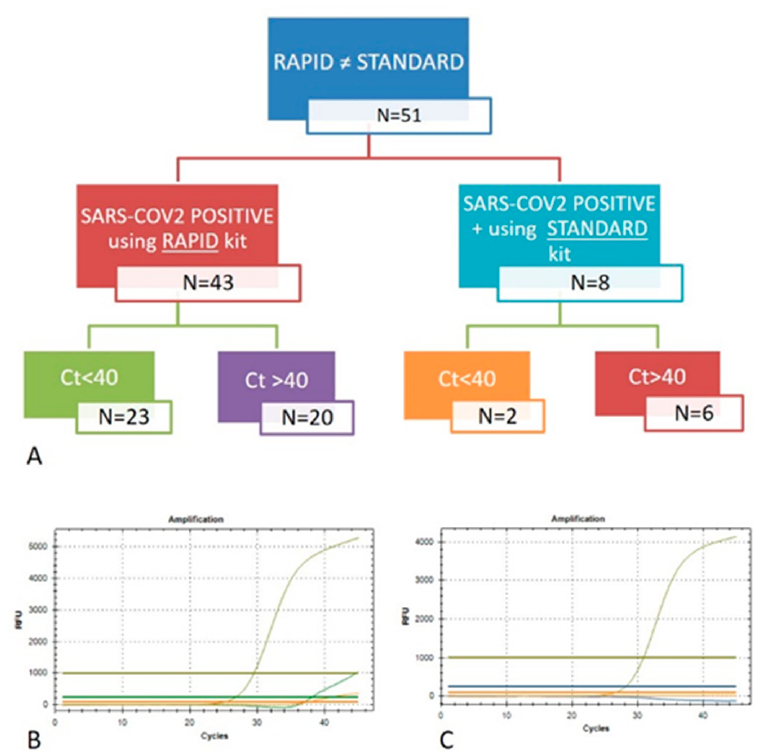
Figure 5. Schematic representation of the samples that showed divergence in SARS-CoV-2 detection ( A ). Examples of the qPCR curves obtained for the analysis of the same samples after extraction with the rapid ( B ) and standard ( C ) kits that showed different results.